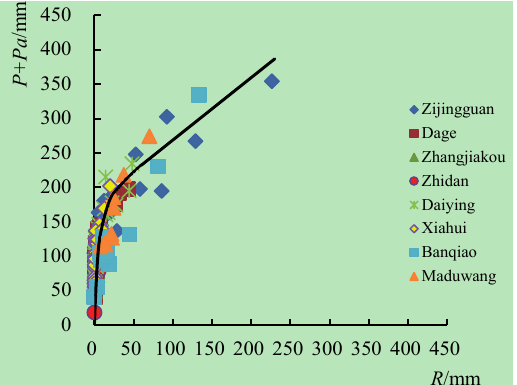
Fig. 2 Integrated coaxial correlation diagram for all the catchments. Table 2 Comparison of performance based on the separated and integrated coaxial correlation diagrams. Station